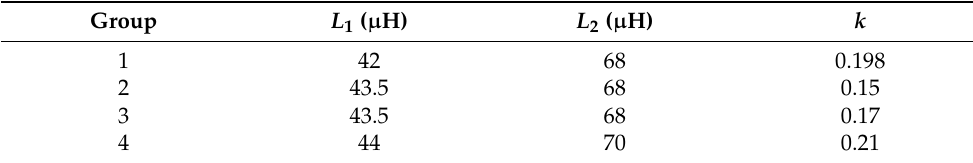
Table 5. Multi group coupling coil parameters.